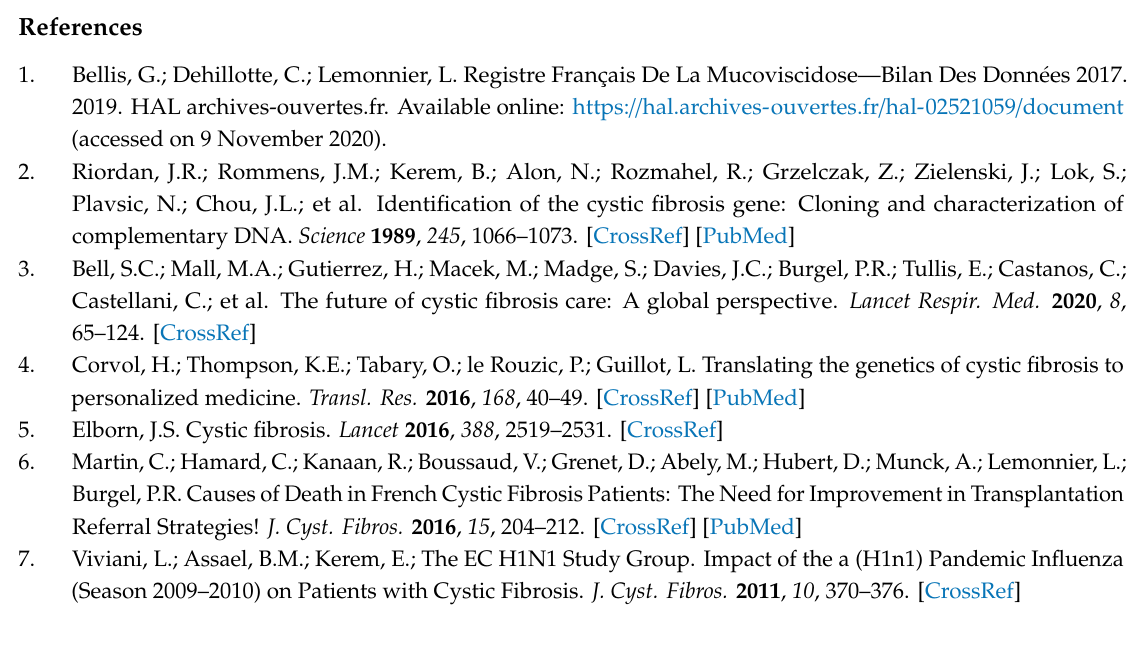
Figure S1: Observed and expected number of COVID-19 cases in French patients with cystic fibrosis according to age class, Table S1: COVID-19 cumulated incidence in the French general population, number and age (expected and observed) of COVID-19 in French cystic fibrosis patients, Table S2: Symptoms of the 11 CF patients for whom the diagnostic of SARS-Cov-2 infection was assessed by a positive serology, Table S3: Comparison of the clinical characteristics of the 31 CF patients at SARS-CoV-2 infection onset to the overall French CF population from the national registry, Table S4: Baseline clinical characteristics of the 4 patients who required ICU care, Table S5: Evolution of the 4 patients who required ICU